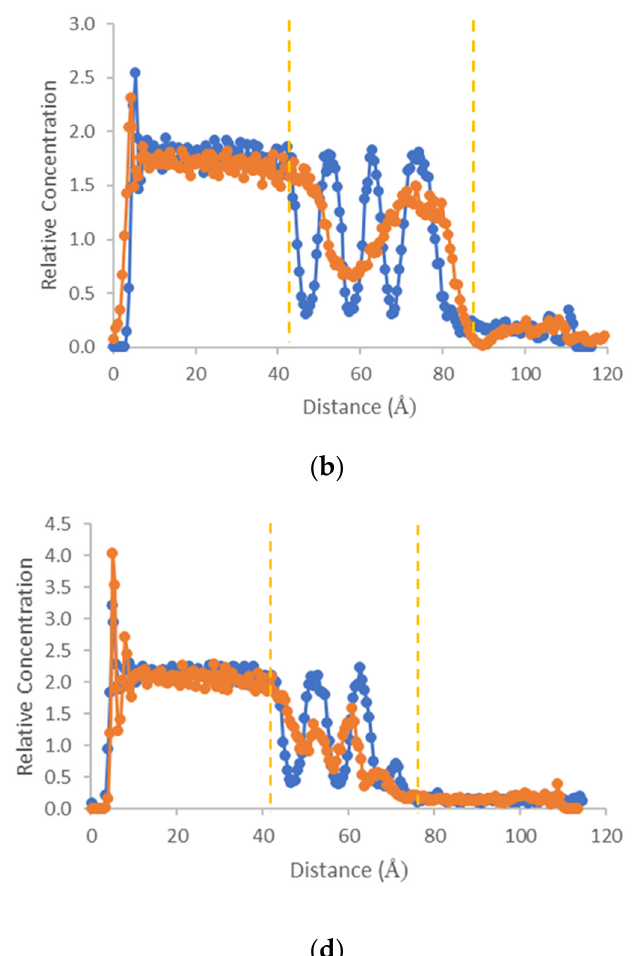
Figure 5. Density profile perpendicular to GO sheets at the beginning of the simulation (blue lines) and at the end (orange lines) for ( a ) GO in water; ( b ) PVDF; ( c ) PAI; and ( d ) PAI-cr, as a function of the distance from the top edge of the box. The yellow dashed lines denote the boundaries of the stacks of the GO layers.